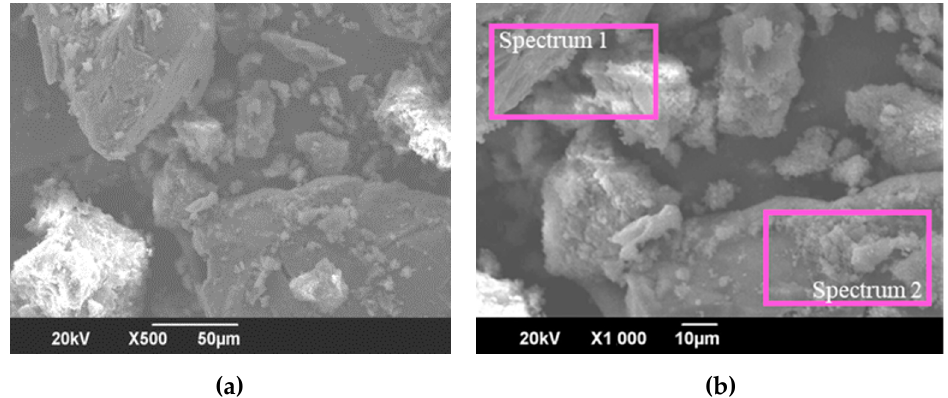
Table 7. Initial condition of the wetting–drying samples.